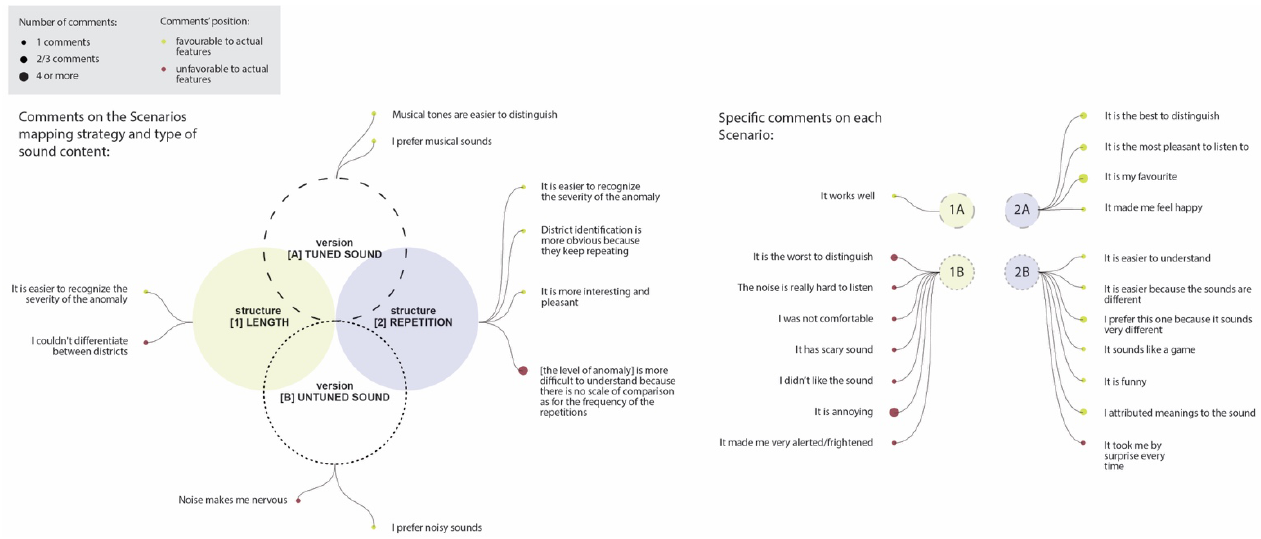
Figure 5 . Analysis of clustered results for the four